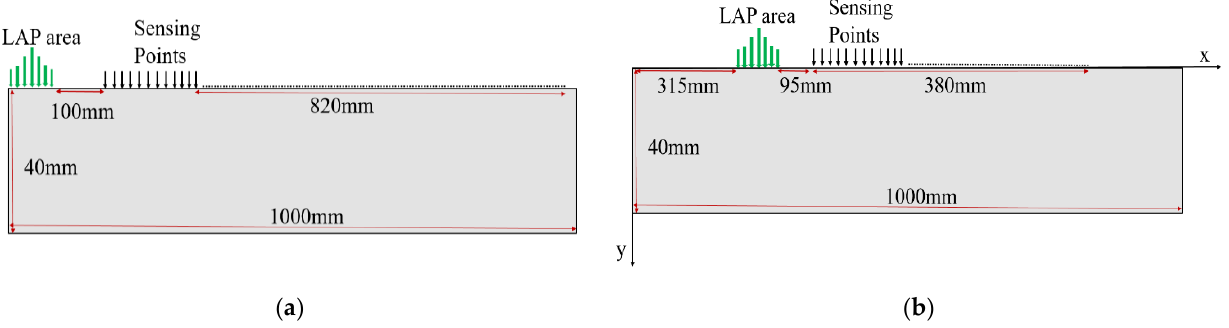
Figure 5. Schematic representation of experimental arrangements on healthy specimen A: ( a ) for wave propagation study and ( b ) to design dictionaries.